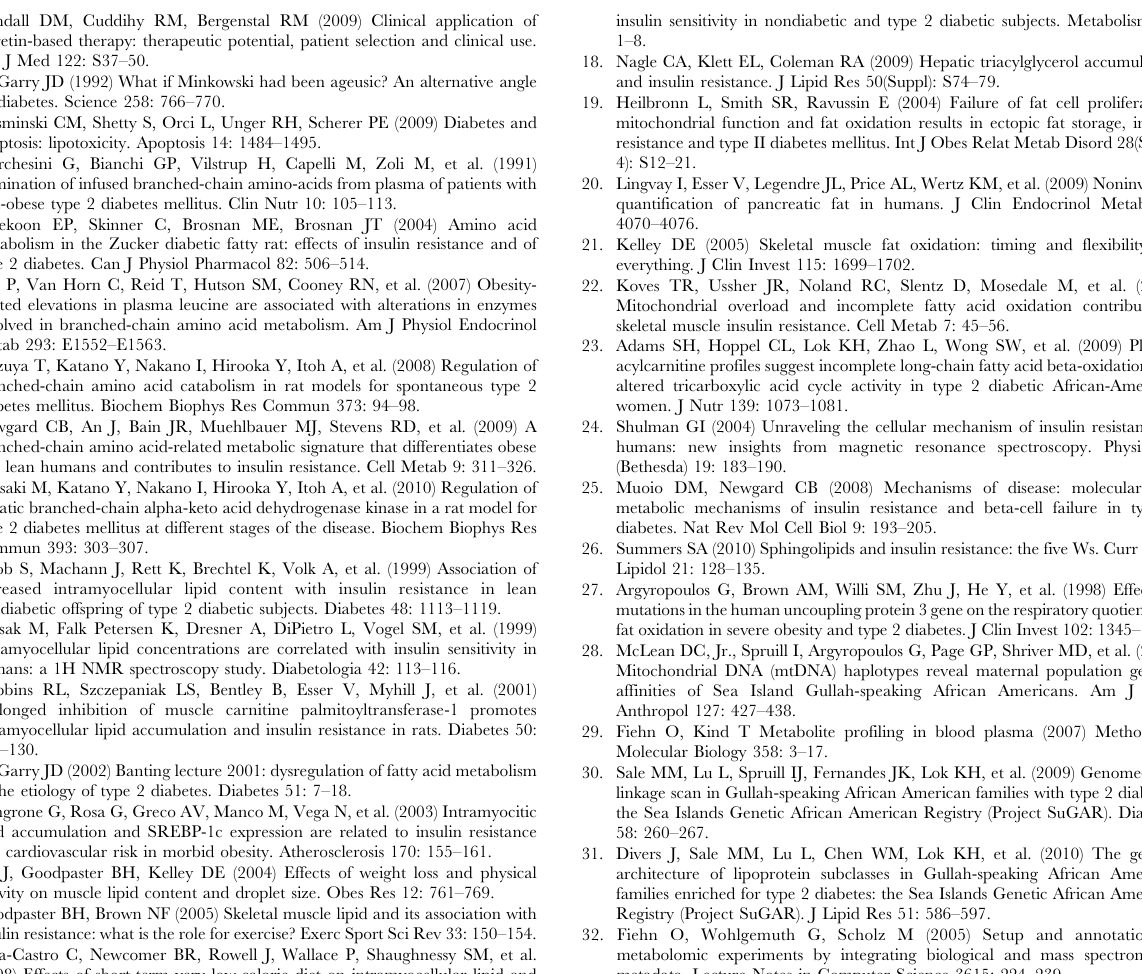
Table S1 Plasma Metabolite list comparing UCP3 g/g and g/a polymorphs in an obese, African-American cohort of women. Values are quantifier peak heights deter- mined for each subject used in the analyses, and metabolites are identified in the leftward column. Mass spec information is provided in columns B–E, and in some cases, KEGG identifiers are provided. Unpaired t-tests were used to evaluate non-diabetic genotype differences, as noted. Table S2 Plasma Metabolite list comparing type 2 diabetic and non-diabetic obese African-American wom- en. Values are quantifier peak heights determined for each subject used in the analyses, and metabolites are identified in the leftward column. Mass spec information is provided in columns B–E, and in some cases, KEGG identifiers are provided. Unpaired t-tests